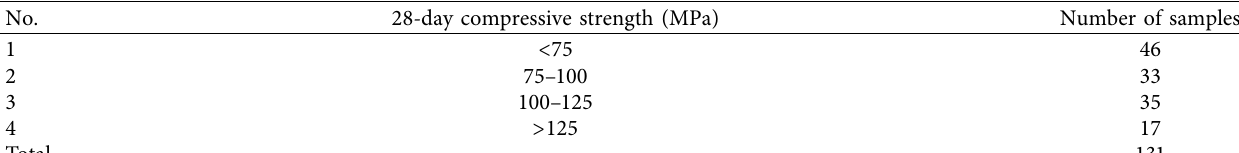
Table 2: Number of samples in each specific range of 28-day compressive strength.